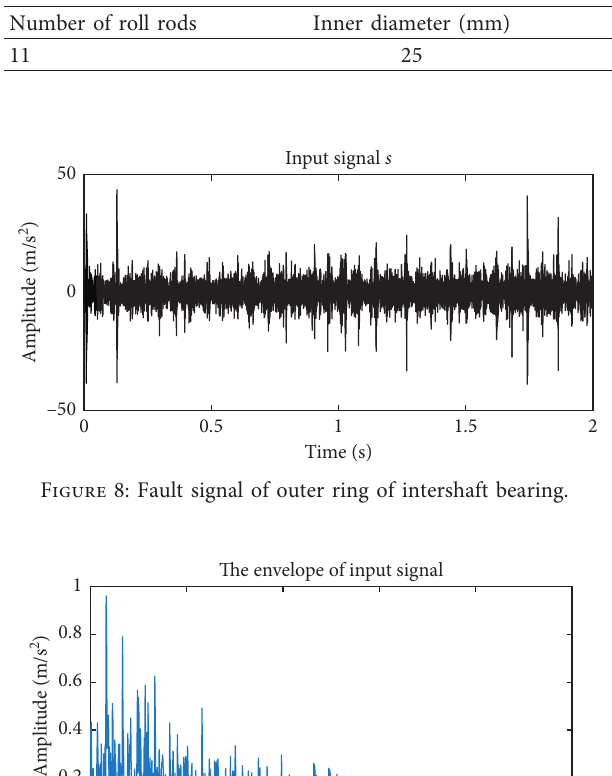
Figure 7: Intershaft bearing with faults: (a) outer ring fault and (b) inner ring fault. Table 1: Parameters of intershaft bearing.